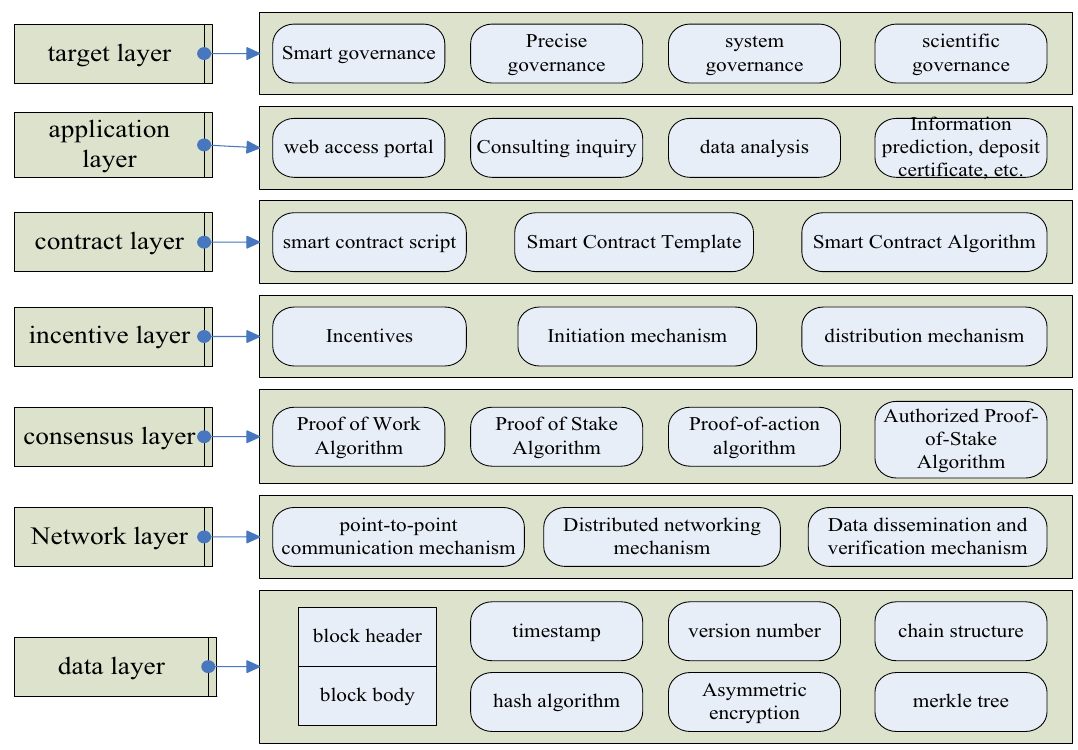
Fig. 2 Basic architecture of blockchain